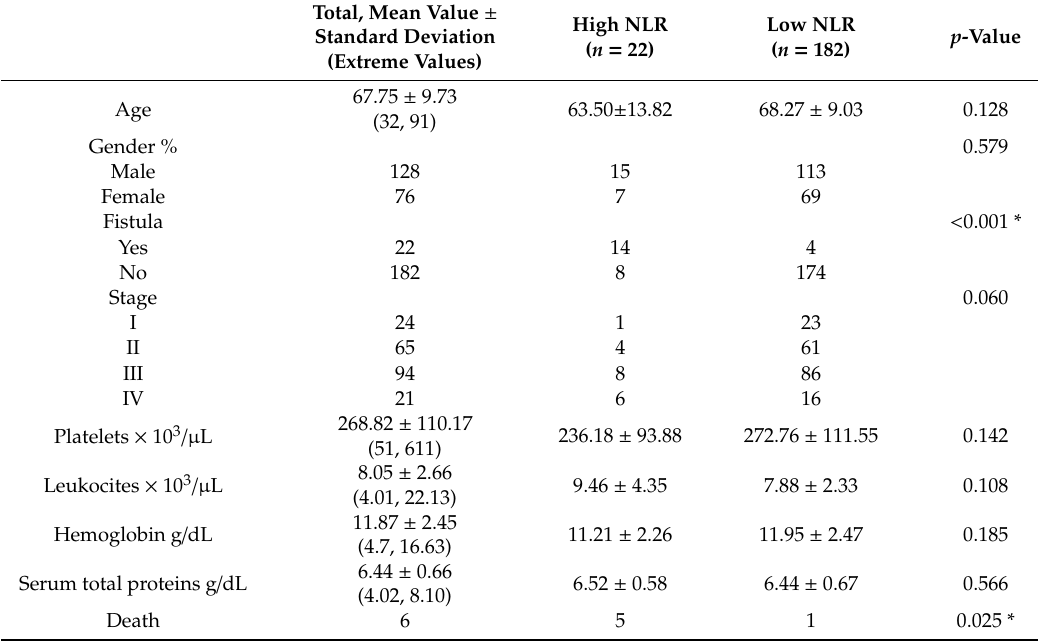
Table 1. Characteristics of the groups with high NLR and low NLR, respectively.